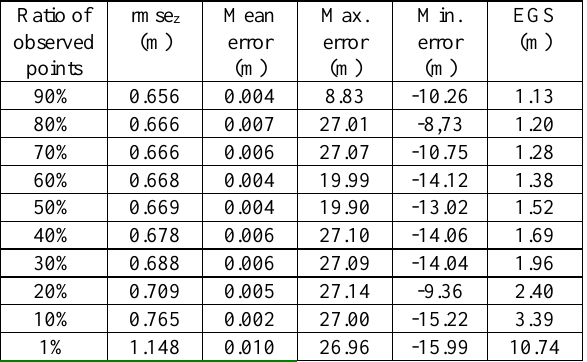
Table 2. Vertical accuracy of GMRF-computed DSMs (1 m grid spacing) depending on the ratio of observed points relative to the total. σ p = 1 m in all cases. EGS = Equivalent Grid Spacing